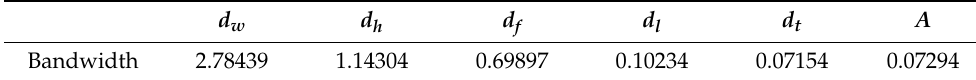
Table 6. Bandwidth of